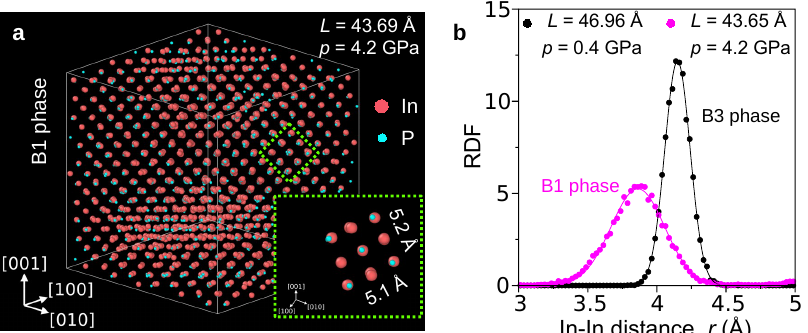
Figure 2. Results of MD simulations presenting details of the high-pressure phase of undoped InP. ( a ) Inspection of the supercell right after the phase transformation shows atomic arrangement of the high-pressure phase. Visualization of the unit cell of the high-pressure phase proves that it possesses the B1 structure; ( b ) radial distribution function (RDF) calculated for In-In bonds. Location of the RDF peak facilitates estimation of the mean value of both B3 and B1 lattice